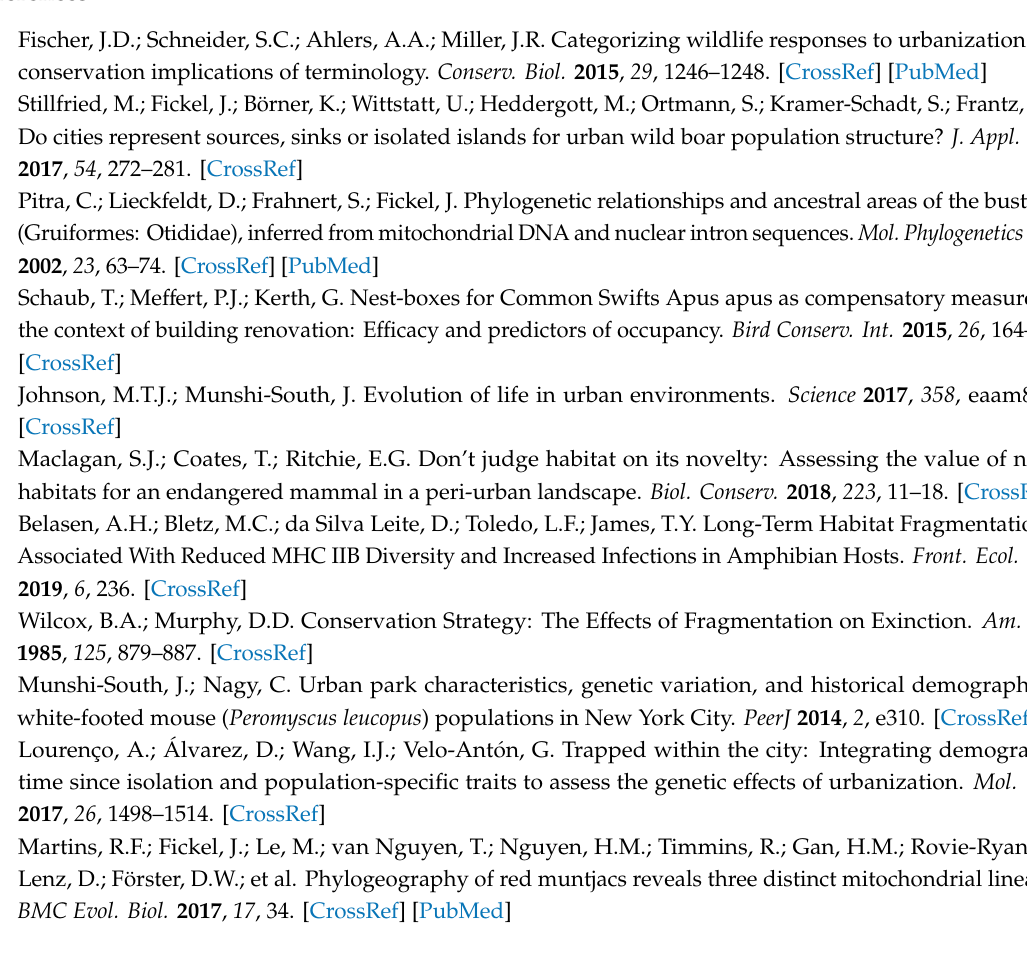
Table S1: Origin of samples ( N = 143), Table S2: Unique genotypes ( N = 143) of hedgehogs in Berlin across ten microsatellite loci, Table S3: Unique genotypes ( N = 65) of unrelated ( r < 0.5) hedgehogs in Berlin across ten microsatellite